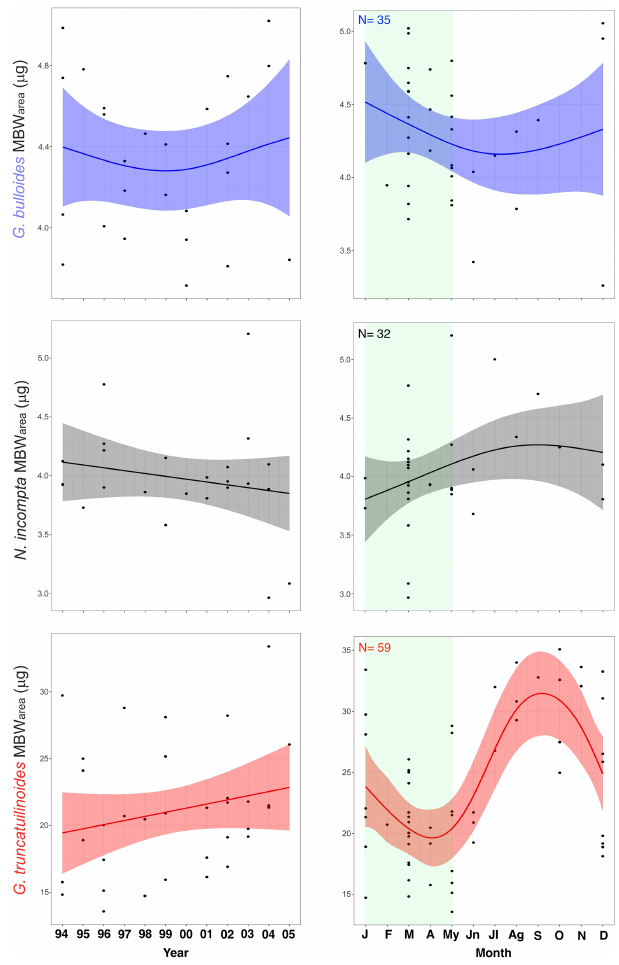
Figure 3. Mean MBW area (µg) values across the years and for a composite year for G. bulloides , N. incompta , and G. truncatuli- noides in the Planier sediment trap. Light-green shaded area rep- resents the high productivity period in the study zone (Rigual- Hernández et al.,